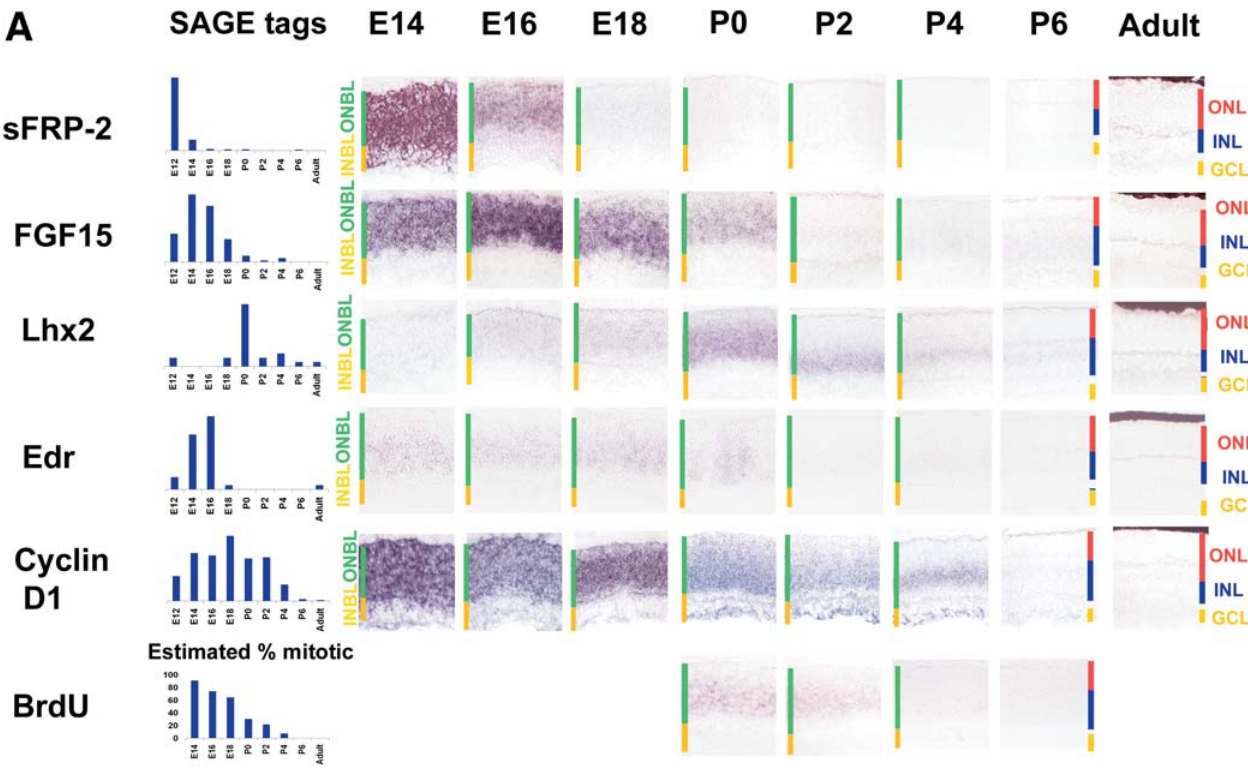
Figure 2. Genes Expressed in Subsets of Mitotic Progenitors (A) Genes expressed in temporally distinct subsets of progenitors. The first column shows relative SAGE tag levels for each gene under consideration. The UniGene identities and common names of the genes in question are Mm.19155/sFrp2, Mm.3904/Fgf15, Mm.142856/Lhx2, Mm.35829/Edr, and Mm.22288/cyclin D1 . The sections for ISH and BrdU shown here were taken from near the center of the retina at the developmental times shown. Mice were albino Swiss Websters except in the case of the adults, which were pigmented C57B/6. See Table S5 for a full list of probes used. Cellular laminae of both the developing and mature retina are indicated with colored bars. All pictures were taken at 200x. The graph plotting the fraction of mitotic cells in the retina adjacent to the BrdU staining is an estimate based on data from both rat and mouse (Young 1985a, 1985b; Alexiades and Cepko. 1996). (B) Spatially heterogeneous ONBL. Genes that were expressed in spatial subsets of cells in the prenatal ONBL are shown. The genes shown are Mm.4541/Sox2, Mm.18789/Sox4, Mm.4605/Tbx2, Mm.29067/Mbtd1, Mm.2229/Eya2, Mm.34701/Pum1, Mm.29924/Arl6ip1, Mm.11738/Ark-1, Mm.40321/ Pgrmc2, and Mm.22288/cyclin D1 . Sections were from central retina. Cellular laminae of both the developing and mature retina are indicated with colored bars. All pictures were taken at 200x. See Table S5 for a full list of probes used. DOI: 10.1371/journal.pbio.0020247.g002